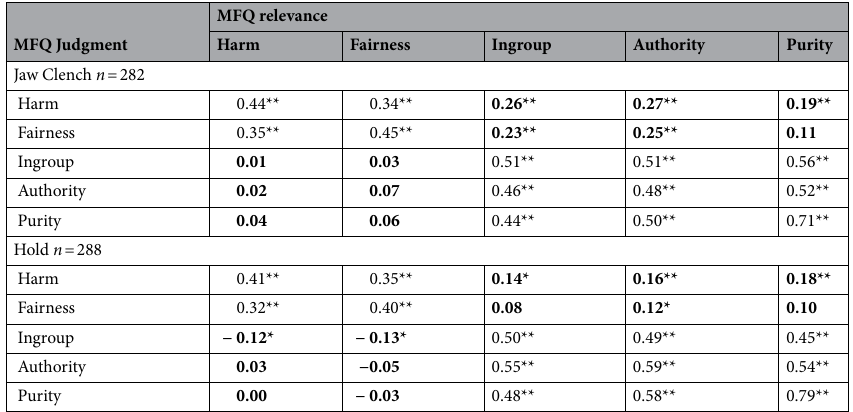
Table 1. MFQ judgment and relevance correlations. We could not run simple correlation difference tests because of the number of correlations we needed to compare. Also, averaging the correlations in each condition would have reduced the number of observations we could compare, thus inflating the probability of a type II error. Therefore, using the off-diagonal correlations in this table (which correspond to correlations between individualizing and binding foundations), we compared clench and control conditions looking for correlation differences (24 correlations). We ran a t-test using the standardized correlation scores as data inputs. We tested for differences between correlations belonging to clenching and holding conditions. Bold Font indicates correlations that have been standardized (z-transformed) and compared between conditions. *Indicates significance at the 0.05 level. **Indicates significance at the 0.01